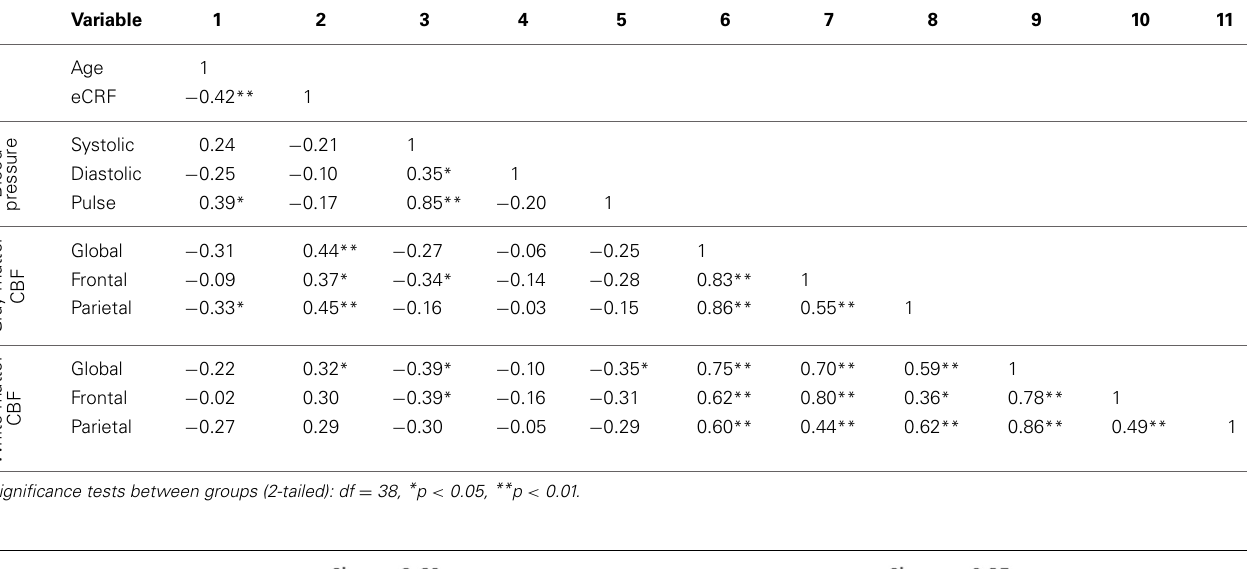
Frontiers in Aging